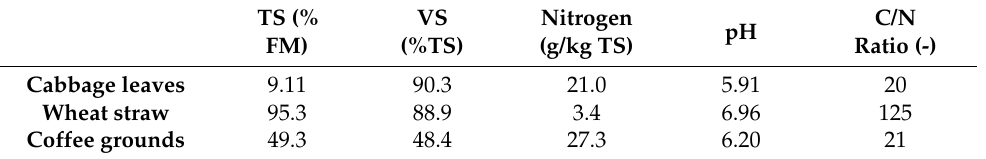
Table 1. Characteristics of materials used in composting experiments.